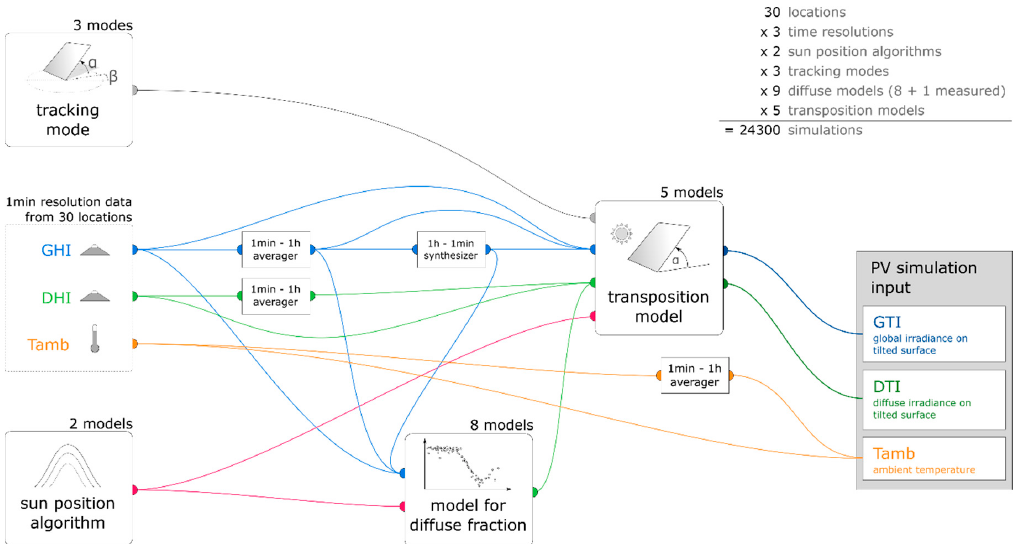
Figure 1. Schematic overview over the matrix simulations. The model chain for the electrical simulation of the PV system is simplified with the grey block on the right. The combination of all models and inputs leads to a total of 24,300 simulations. Table 2. Overview over the dimensions of the matrix simulation.